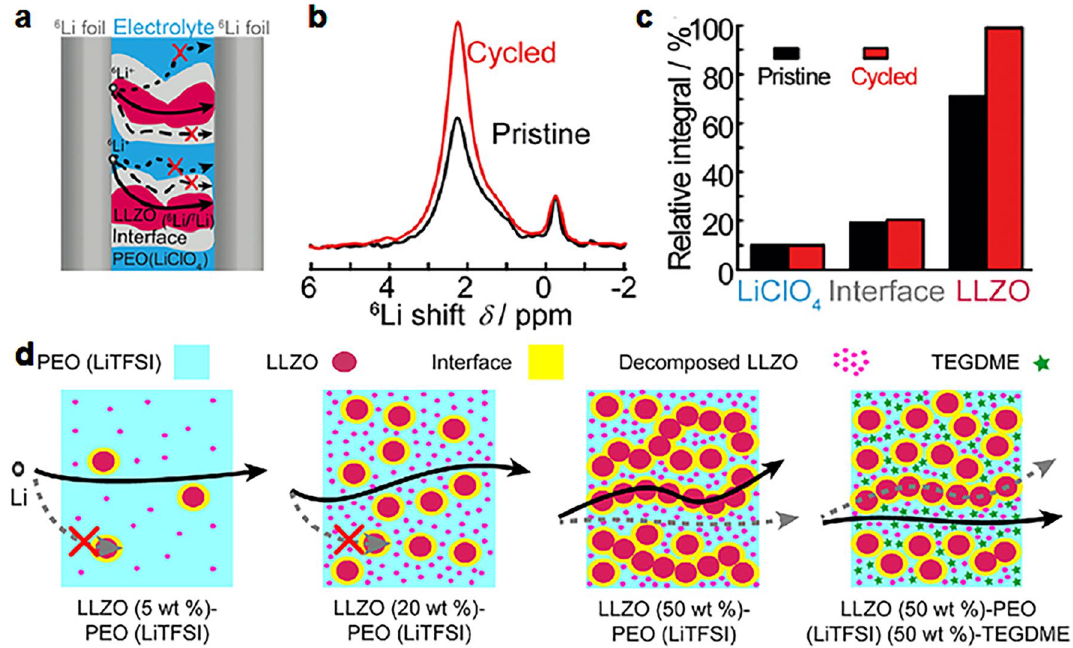
Fig. 3 a Illustration of the symmetric 6 Li battery and possible Li + conduction pathways. b Comparison of the 6 Li spectra of the LLZO/ PEO(LiClO 4 ) electrolytes before and after cycling. c Quantitative analysis of the 6 Li amount in LiClO 4 , the interface, and LLZO of LLZO/ PEO(LiClO 4 ) before and after cycling. a – c Reproduced with permission [104]. Copyright 2016, Wiley–VCH. d Schematic of Li + pathways within CSEs. Reproduced with permission [77]. Copyright 2018, American Chemical